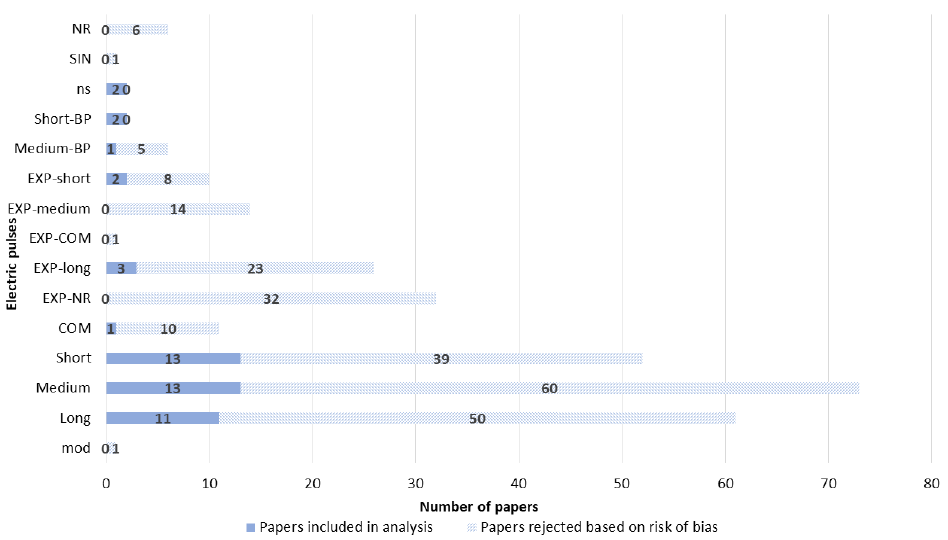
Figure 7. Amplitude and duration of the electric pulses used in the GET experiments. Short: 1–499 µs; medium: 500 µs–9.9 ms; long: 10 ms or longer; nanosecond pulses (ns): less than 999 ns; or combinations of pulses (COM), exponential pulse (EXP-short, EXP-medium, EXP-long, and EXP-COM), RF-modulated square wave pulse (mod), sinusoidal (SIN), bipolar square wave pulse (short-BP and medium-BP), NR—not reported.